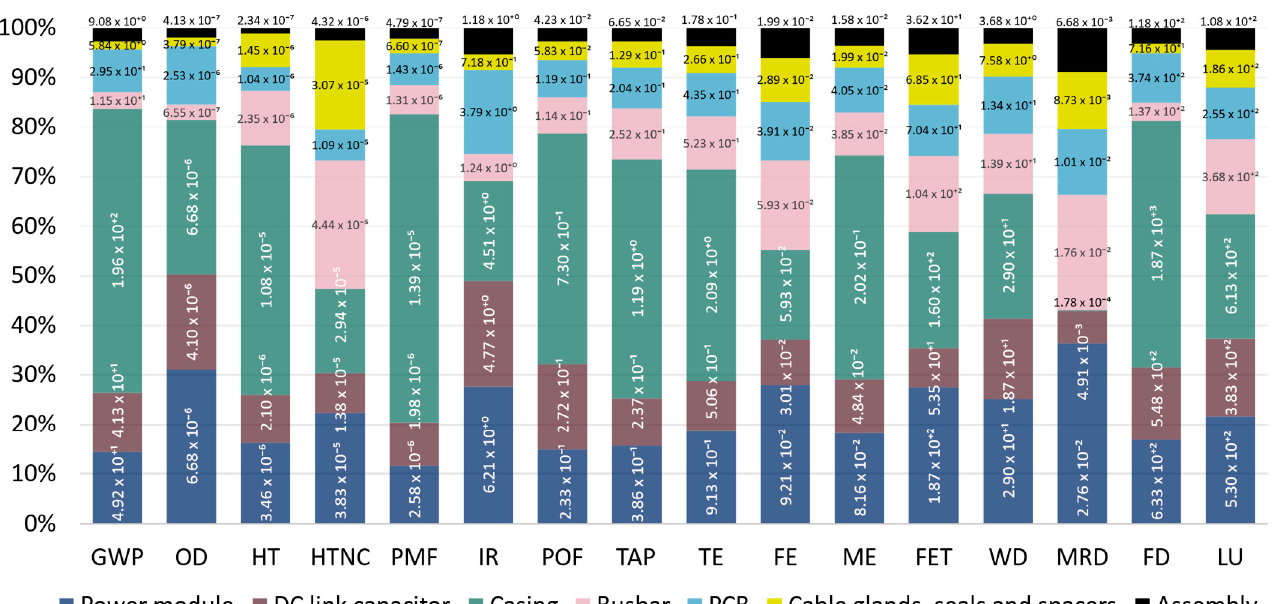
Figure 5. Standardized environmental impacts of the “gate-to-gate” manufacturing phase, at the inverter operating point for a 150 kW load, from a DC power source of 450 V, in applying the European Commission recommendations for choosing impact categories [27]. The associated abbreviations are presented in Table 1.